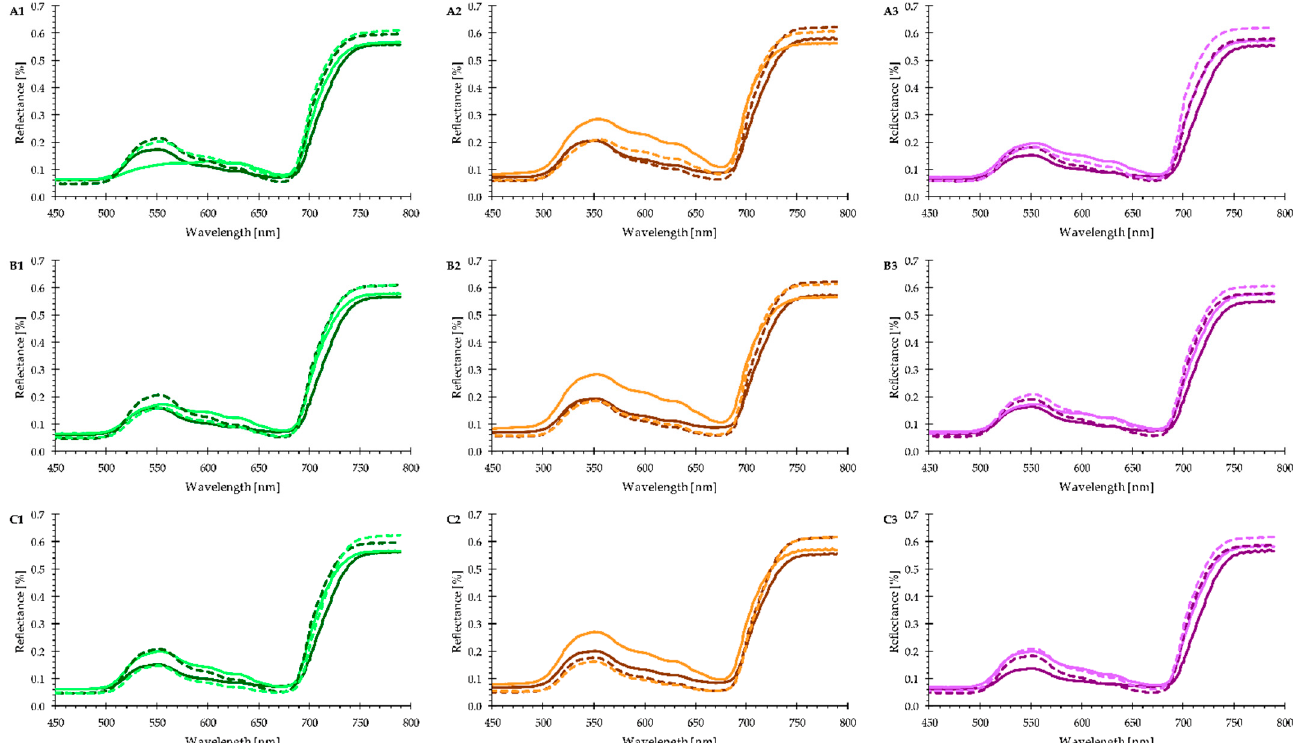
Figure 8. Reflectance spectra of three different H. macrophylla subsp. serrata cultivars ( 1 : ‘Oamacha’, 2 : ’Odoriko Amacha’, 3 : ‘Amagi Amacha’) under three different shading regimes (( A ): no shade, ( B ): partial shade, ( C ): full shade). Full lines represent 2018 and dotted lines 2019, with dark coloring representing first and light coloring representing last day of measurements. Full data of reflectance spectra can be found in the Supplementary Materials Table S4.